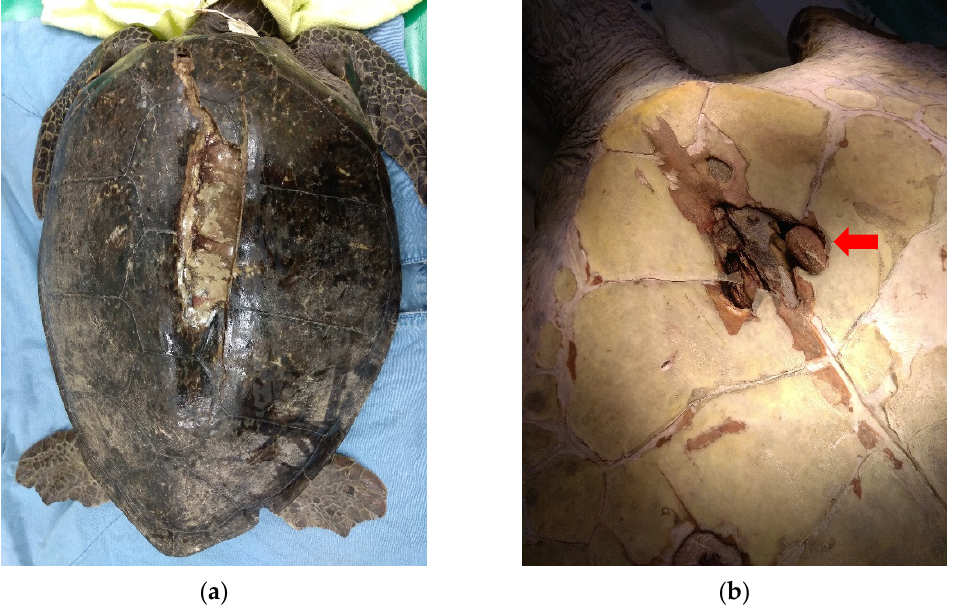
Figure 1. ( a ) After initial wound debridement, a large carapace defect with lung exposure was observed. ( b ) The left acro- mion process of the pectoral girdle (red arrow) was visible through the plastron defects located at the gular scutes and exhibited severe osteomyelitis with the presence of abundant